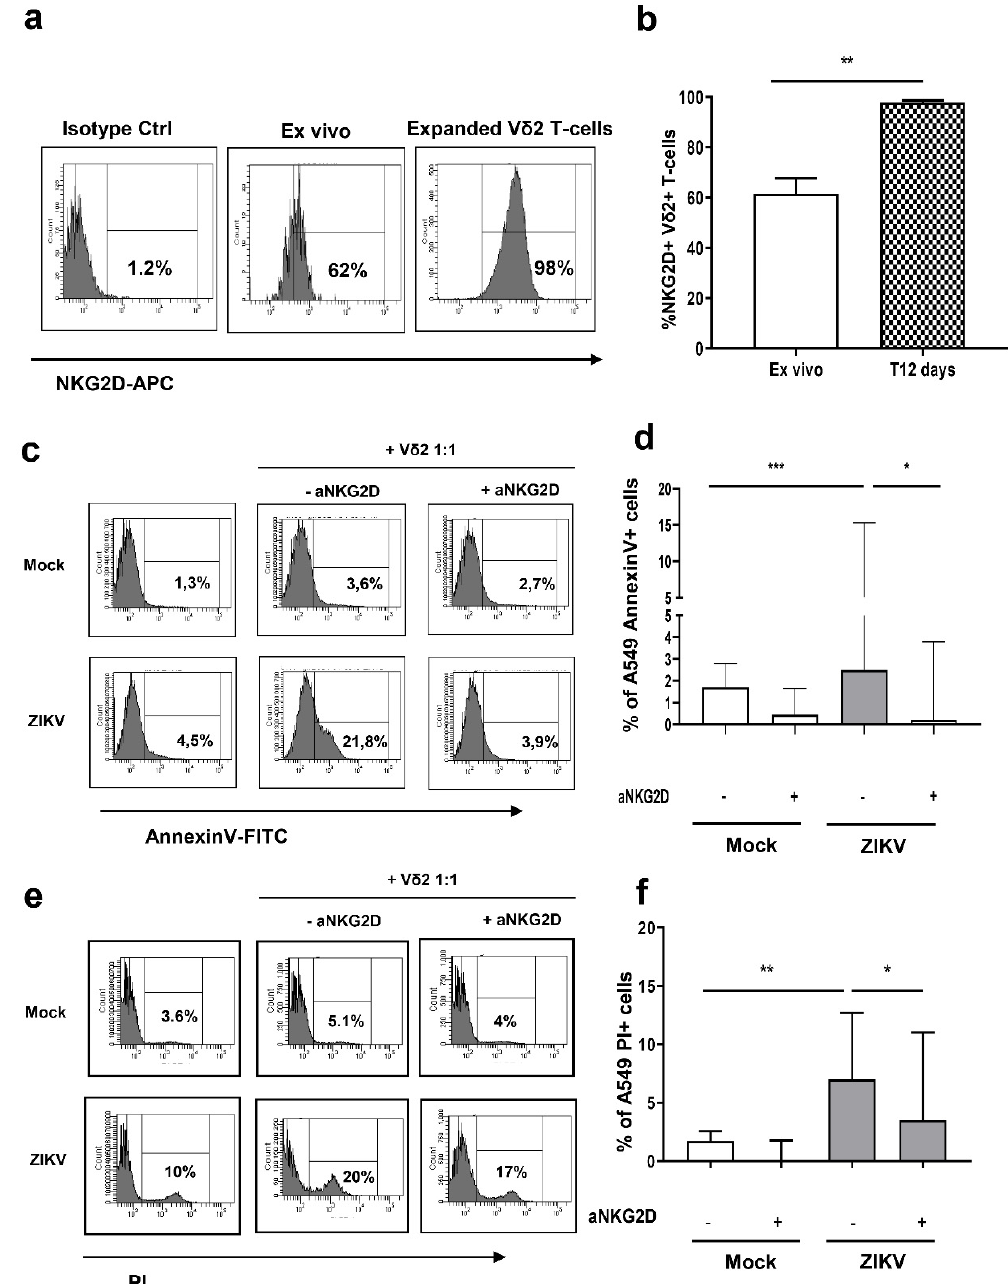
Figure 5. ZIKV sensitizes A549 cells to NKG2D-mediated killing by V δ 2 T-cells. ( a ) Flow cytometric panels showing the expression of NKG2D receptor on V δ 2 T-cells ex vivo and after 12 days of PhAg + IL-2 stimulation (V δ 2 T line) in a representative experiment. ( b ) The frequency of NKG2D + cells among V δ 2 T-cells was compared in 9 experiments at T0 (white bars) and T12 days (squares bars). ( c ) Flow cytometry panels showing the expression of AnnexinV on mock / ZIKV-infected A549 cells after co-culture at E:T ratio of 1:1 with V δ 2 T-cells pre-treated or without blocking a-NKG2D antibody. ( d ) Comparative analysis of 9 independent experiments as the one depicted in panel C is shown. ( e ) Flow cytometry panels showing the expression of PI on mock / ZIKV-infected A549 cells after co-culture at E:T ratio of 1:1 with V δ 2 T-cells pre-treated or without blocking a-NKG2D antibody. ( f ) Comparative analysis of 8 independent experiments as the one depicted in panel E is shown. In all experiments, background (mock / ZIKV + apoptotic / necrotic cells without expanded V δ 2 T-cells) was subtracted to all conditions. Data were represented as median + interquartile range. * p < 0.05; ** p < 0.01; *** p <